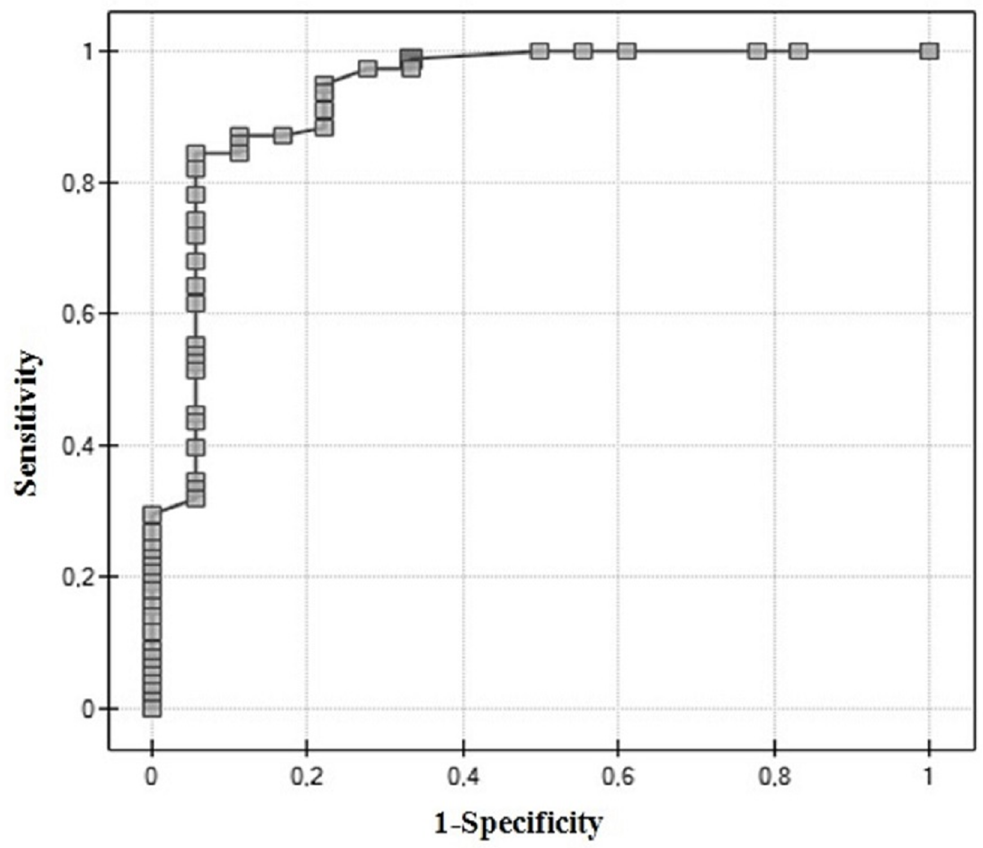
Figure 5. ROC curves for concentration ratio of UCH-L1 to 20S proteasome in serum as diagnostic tests for bladder cancer. The ROC curve yielded an AUC of 0.93 ( p < 0.0001), with sensitivity 98%, specificity 66%, PPV 92%, and NPV 92%. The calculated cut-off point was 0.09.